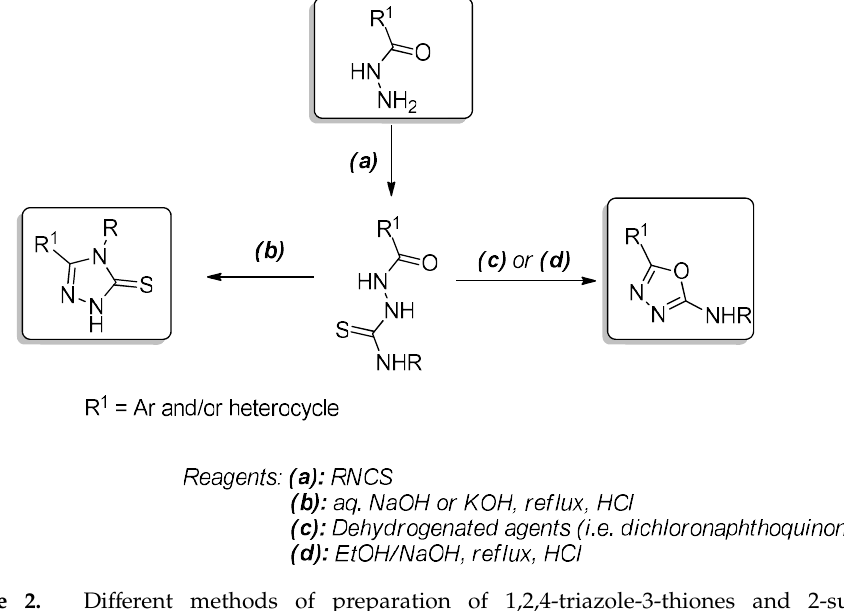
Figure 2. Different methods of preparation of 1,2,4-triazole-3-thiones and 2-substituted amino-1,3,4-oxadiazoles.